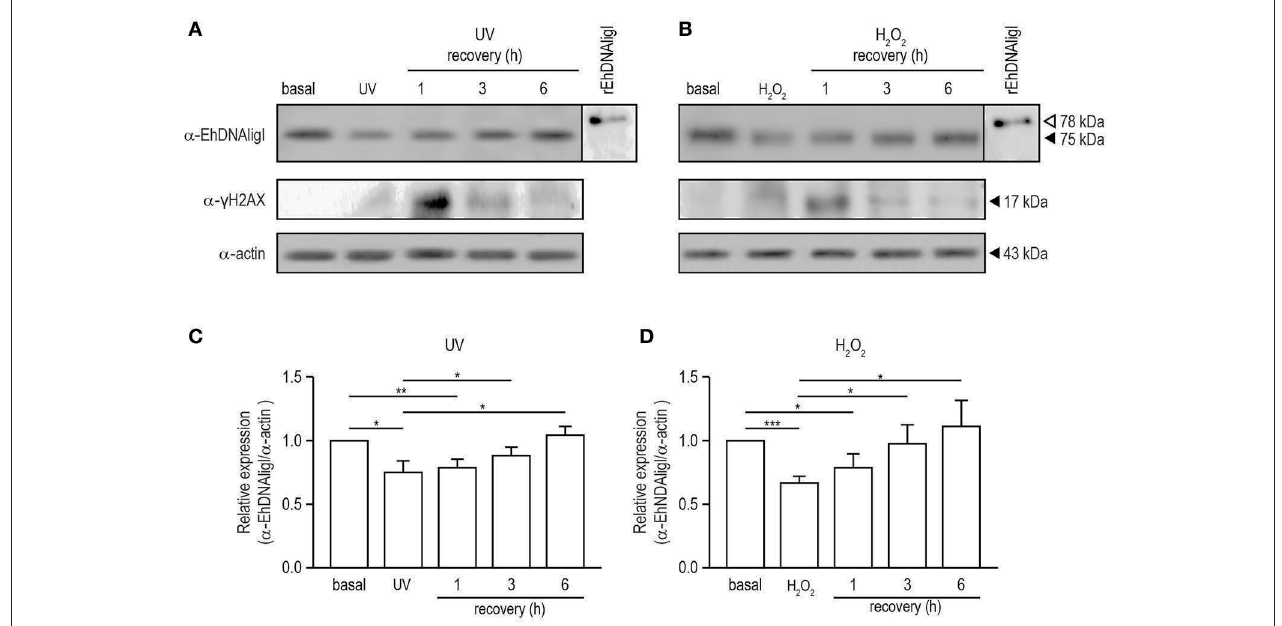
FIGURE 5 | Expression of EhDNAligI in trophozoites recovered of DNA damage induced by UV and H 2 O 2 treatments. (A) and (B) Total lysates from trophozoites in basal condition, immediately or recovered at different times from treatments with UV or H 2 O 2 were immunodetected using the α -EhDNAligI antibody. γ H2AX antibody was used as a control of DNA damage. α -actin antibody was used as loading control and rEhDNAligI was used as positive control. (C,D) Densitometry analysis of bands in (A,B) , respectively. Relative expression of EhDNAligI was normalized using actin and basal condition. Data represent media ± standard error from three independent experiments. * p < 0.05, ** p < 0.01, *** p < 0.001.